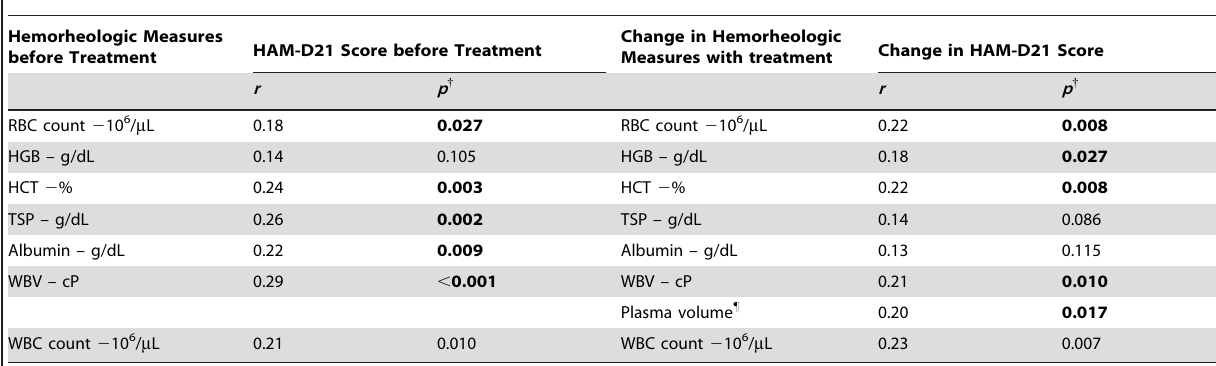
(Table 3). Paired t-test analyses showed that all the six hemorheologic measures and the WBC count in MDD subjects decreased significantly after antidepressant treatment ( p # 0.0003). Table 4. Correlations of HAM-D21 Score, Hemorheologic Measures and WBC Count in MDD Subjects (N=146) Hemorheologic Measures before